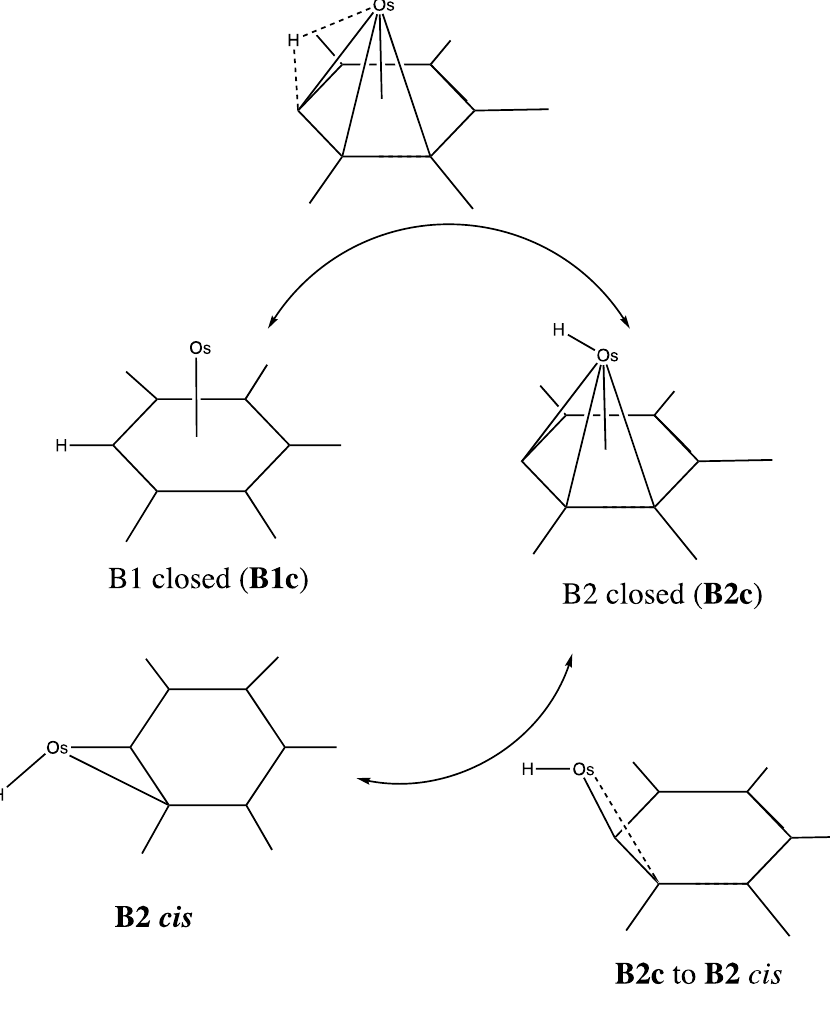
Figure 5. Structures for rearrangements of the most stable OsC 6 H 6 cation species, the doublet com- plex of an Os atom with a phenyl ring.